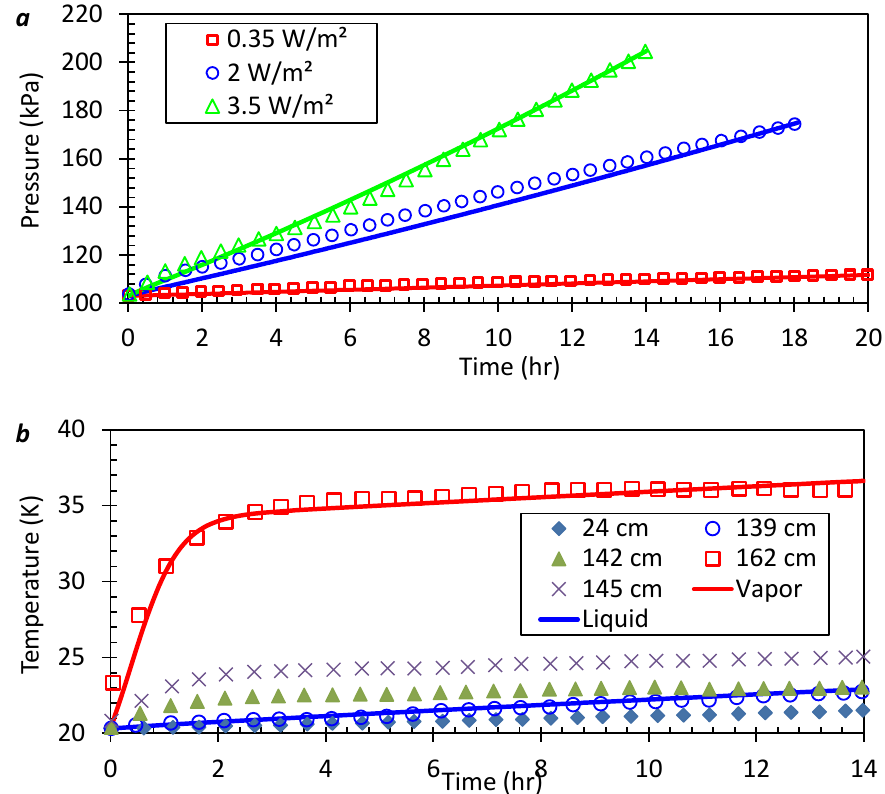
Figure 5. Comparison between the BoilFAST calculations (solid curves) and experimental data (symbols) obtained from a LH 2 storage tank at NASA’s Glenn Research Centre. ( a ) self- pressurization for three different heat fluxes; ( b ) stratified temperature for a heat flux of 3.5 W/m 2 (Test 3), where sensors above 140 cm were in the tank’s ullage region (vapor space).